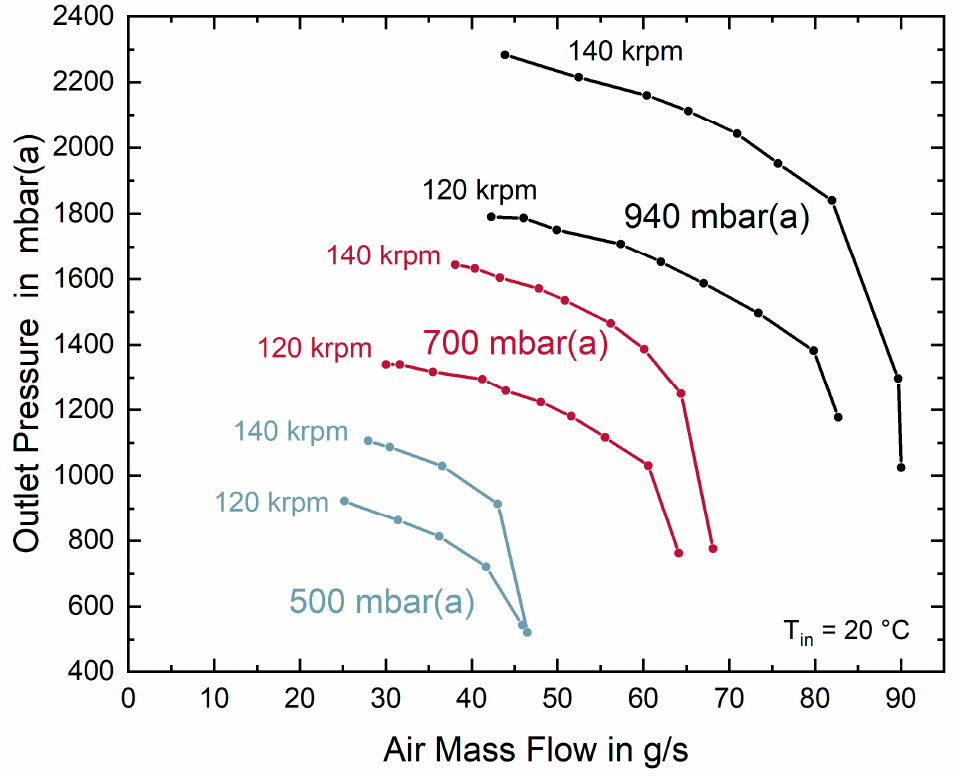
Figure 2. Absolute compressor map for 940, 700 and 500 mbar(a); inlet pressure and compressor speeds of 140 and 120 krpm; and 20 °C inlet temperature.